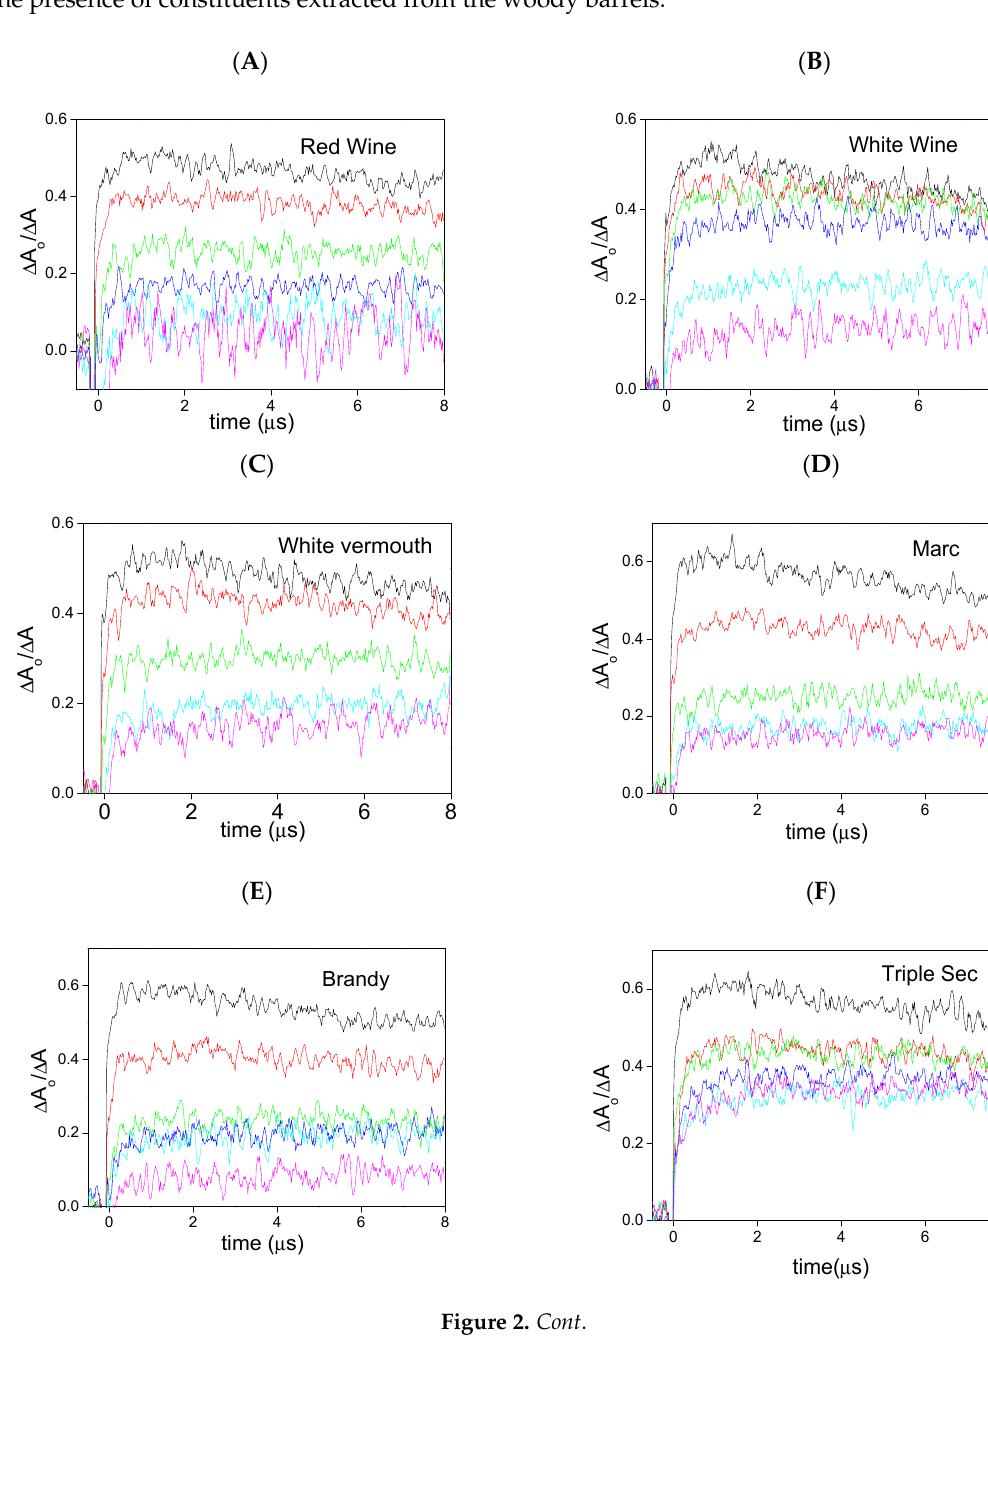
Rum Figure 2. Kinetic traces recorded at 390 nm after laser flash photolysis irradiation ( λ exc = 355 nm) of deaerated acetonitrile solutions of NPT (0.29 mM) and TS (7.5 mM) with increasing volumes of